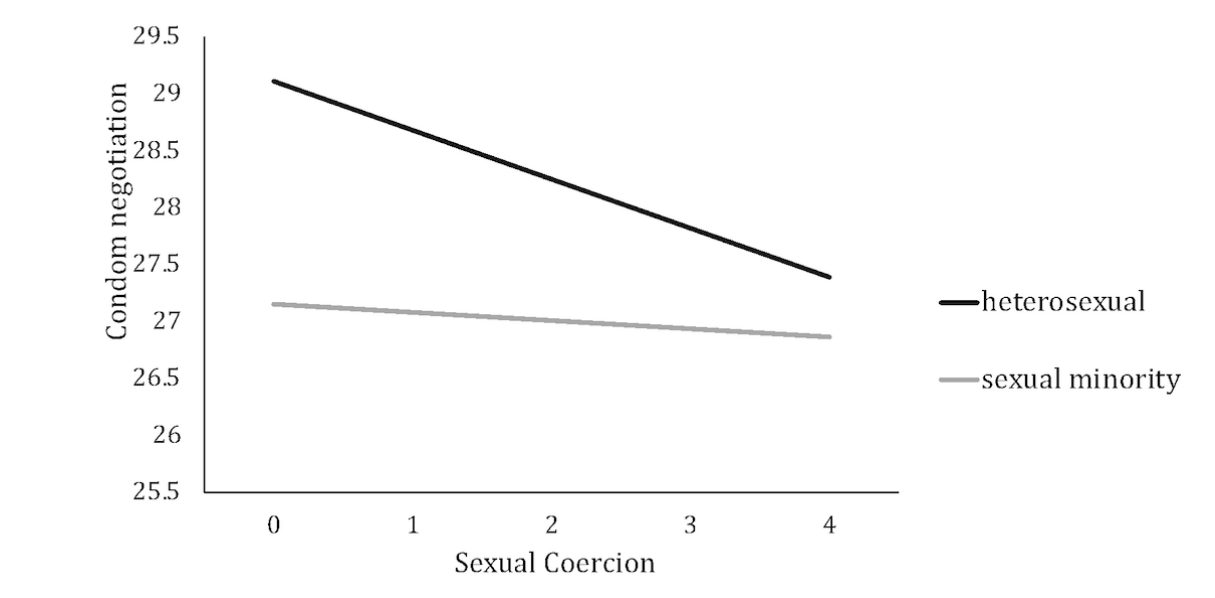
Figure 3. The moderation of the relationship between sexual coercion and condom negotiation by sexual orientation.